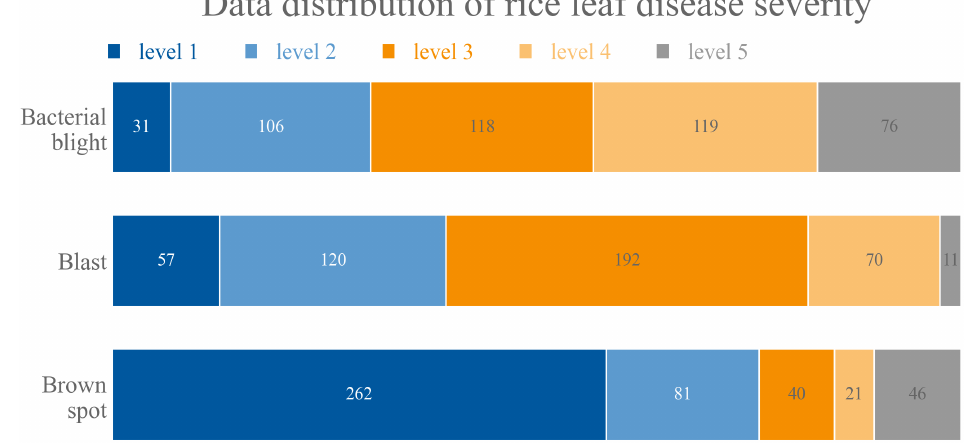
Figure 4. Distribution of five severity levels of three diseases in the rice leaf disease dataset.